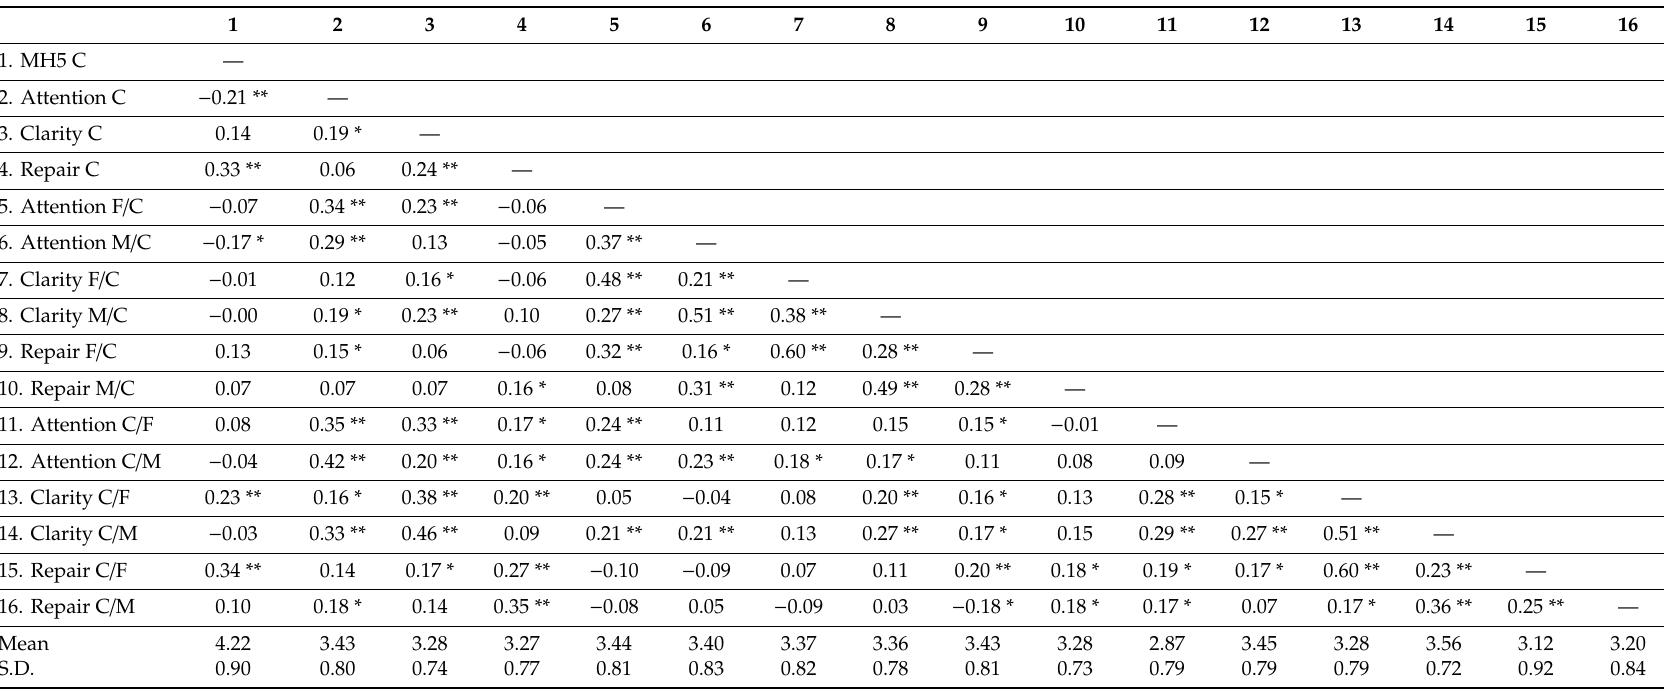
Table 1. Main descriptive statistics and Pearson